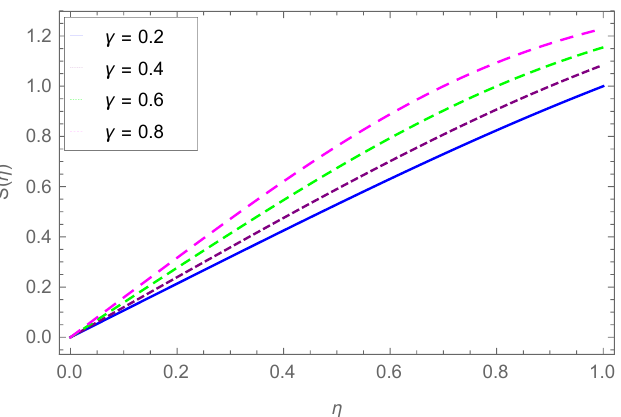
Figure 5. Graph depicting S ( η ) dependence on γ . Figure 6 plots the fluid temperature θ ( η ) for varying α nf . At fixed α nf , there is approximately a direct relation between θ ( η ) and η up to about η = 0.7. The figure also shows that there is an increasing trend in θ ( η ) with the higher values of α nf . This increasing trend is more prominent for the highest value of α nf in the range from η = 0.3 up to η = 0.8. Figure 7 displays the variation in θ ( η ) with changing Prandtl number ( Pr ) values. The figure shows a decreasing behavior with higher values of the Prandtl number. The decreas- ing trend is more significant for the highest value of Pr only for the intermediate values of η . The higher values of the Prandtl number correspond to less thermal diffusivity, which results in a decline in the fluid temperature. The temperature function θ ( η ) shows the opposite behavior with respect to the variation in Pr as compared to the variation with respect to α nf